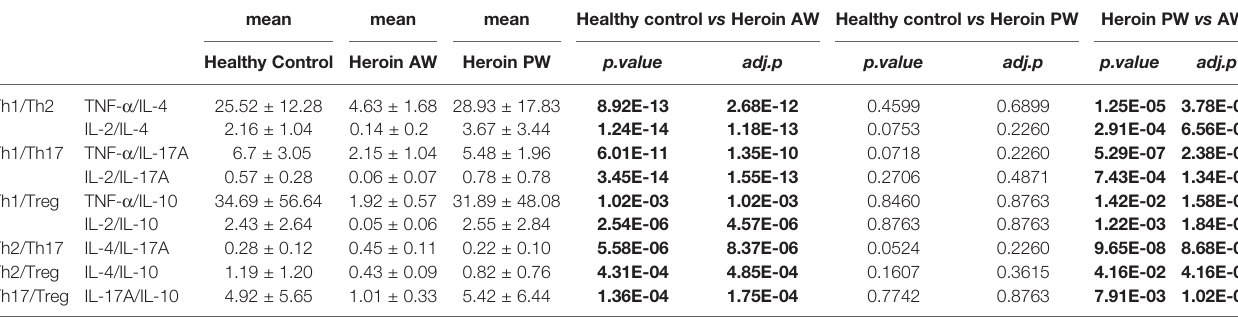
P-values marked with bold indicate statistically signi fi cant differences between the